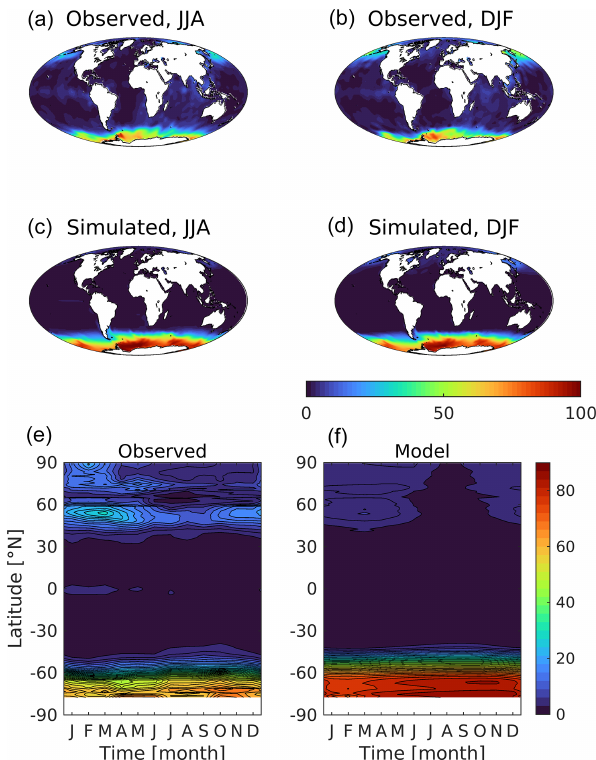
Figure 11. Observational ( a, b ; World Ocean Atlas) and simulated (c, d) surface dissolved silicic acid shown geographically for north- ern ( a, c ; JJA) and southern summer ( b, d ; DJF) and as zonal Hov- möller diagrams (e, f) . Concentrations are given in mmolSim − 3 .